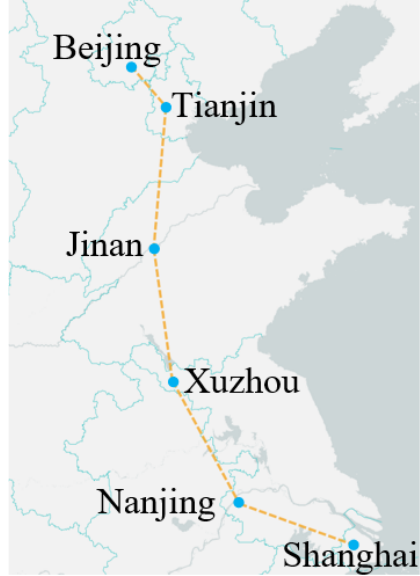
Figure 15. The Beijing–Shanghai HSR line.